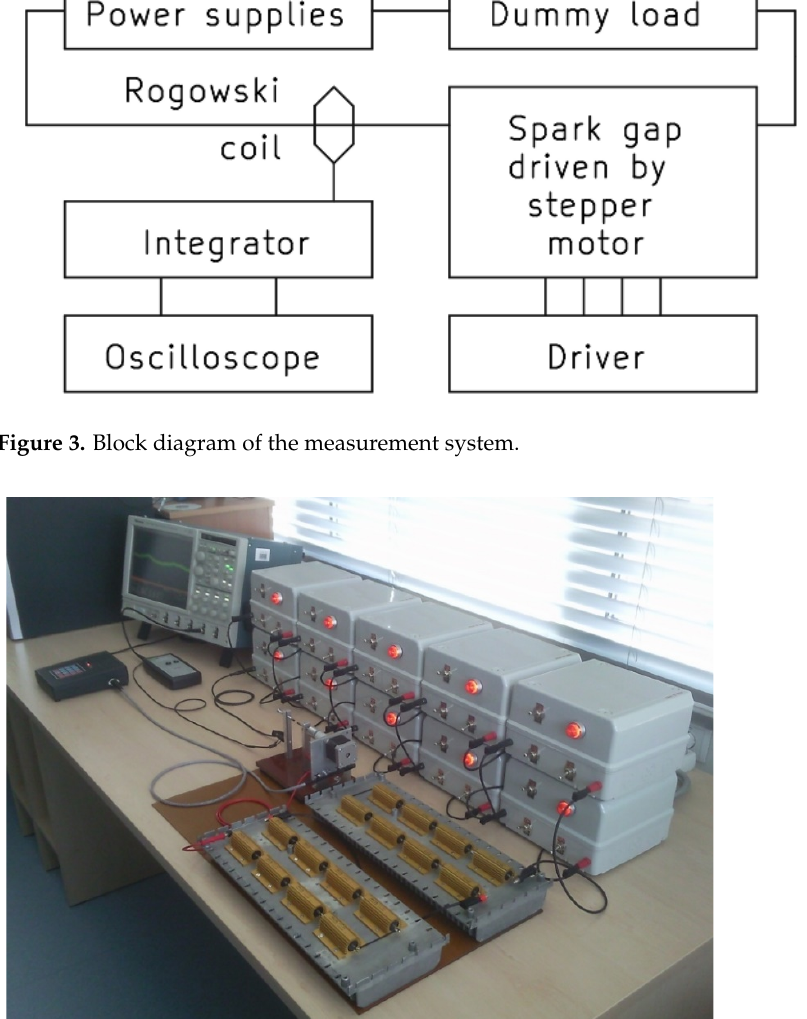
Figure 4. Photo of the measurement system.